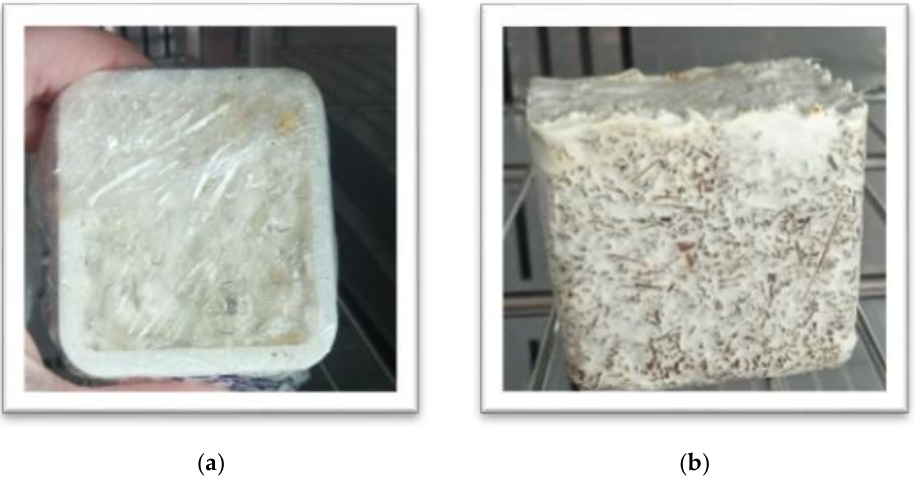
Figure 2. Cultivation of G. resinaceum for obtaining mycelium - based bio - composites: in moulds ( a ) and de - moulded ( b ). ( a ) and de - moulded ( b